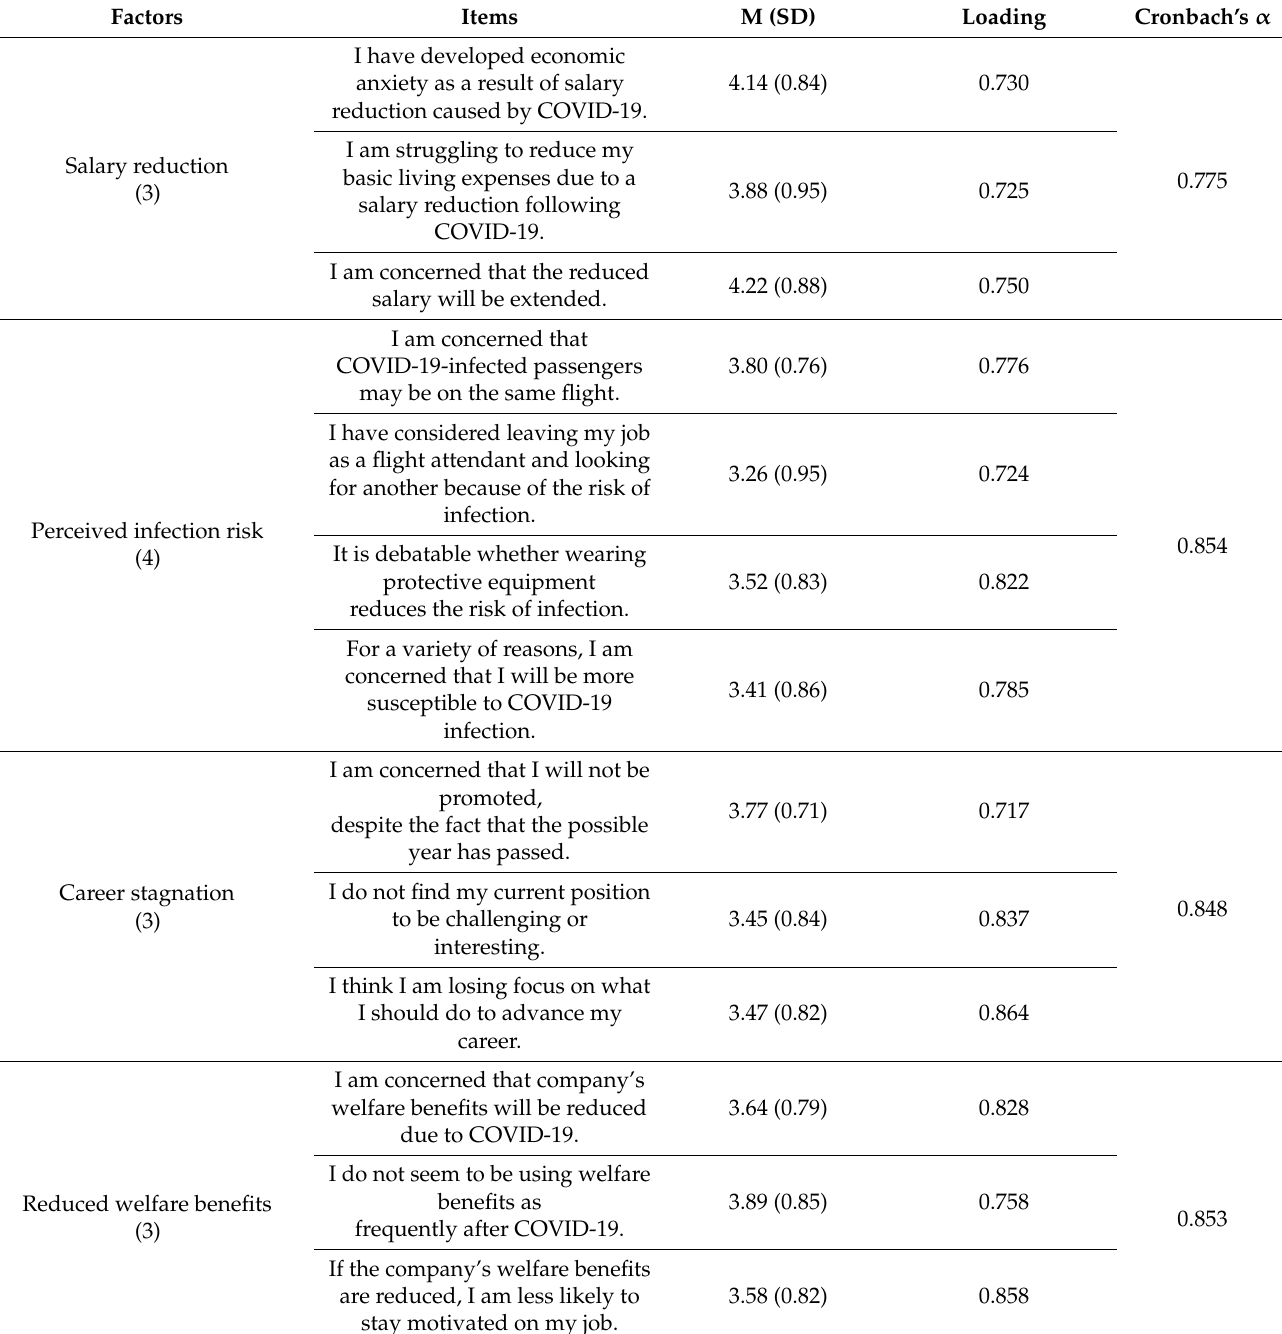
Table 2. Confirmative factor analysis and reliability analysis